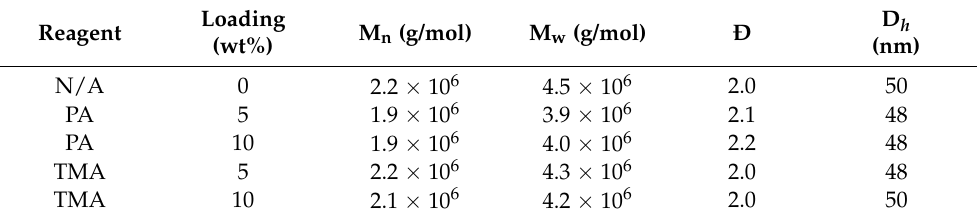
Figure 5. Modification of starch with ( A ) PA and ( B ) TMA. Reaction efficiency at different weight loadings for ( ▲ ) dispersed starch, ( □ ) melt mixer reactions without base, ( ■ ) melt mixer reactions with 1.1 equiv of NaOH, and (x) melt mixer reactions with 2.2 equiv of NaOH. Table 2. Absolute molecular weight averages determined by GPC analysis of starch modified with PA and TMA in the dispersed